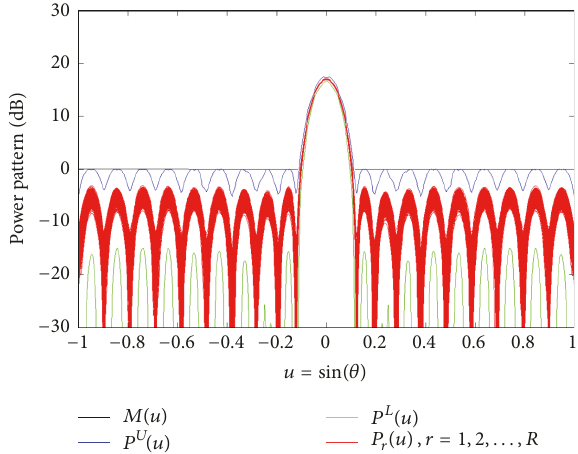
Figure 9: Array radiation patterns using the optimized array excitation ( 𝛿𝛼 𝑛 = 3 %, 𝜂 = 3 ∘